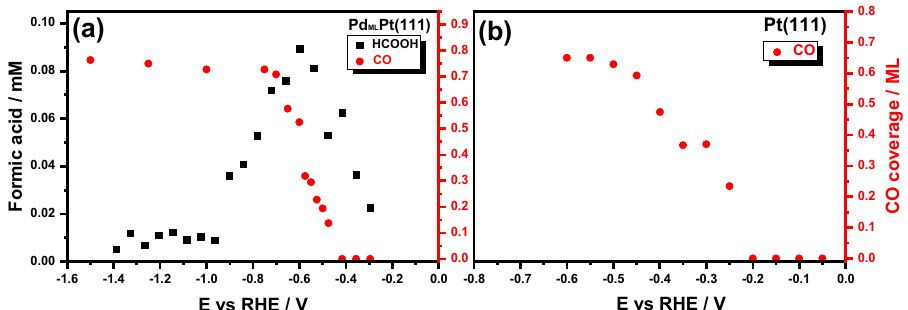
Fig. 3 Formate and CO formation. Formation of formic acid detected with online HPLC and the CO coverage calculated from stripping voltammograms on a Pd ML Pt(111) and b Pt(111) electrode under the same experimental condition.